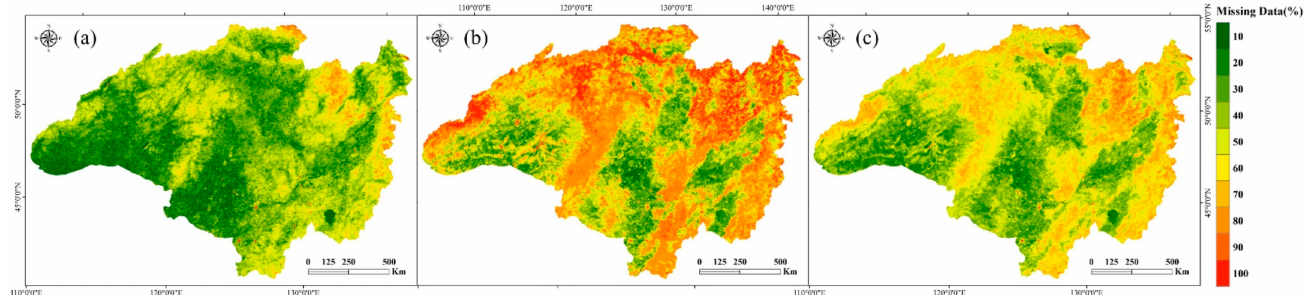
Figure 3. Percentage map of missing data in the MODIS LST image series in growing season ( a ), snowing season ( b ), and the whole year in 2010 ( c